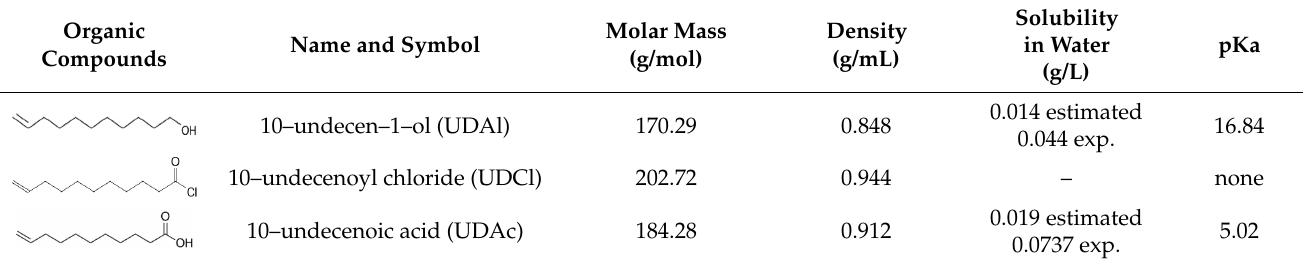
Table 1. The characteristics of the used organic compounds.